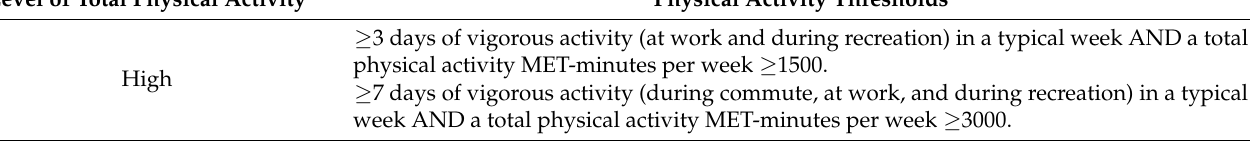
Table 1. Total physical activity levels and classification criteria recommended for use with the Global Physical Activity Questionnaire. Level of Total Physical Activity Physical Activity Thresholds